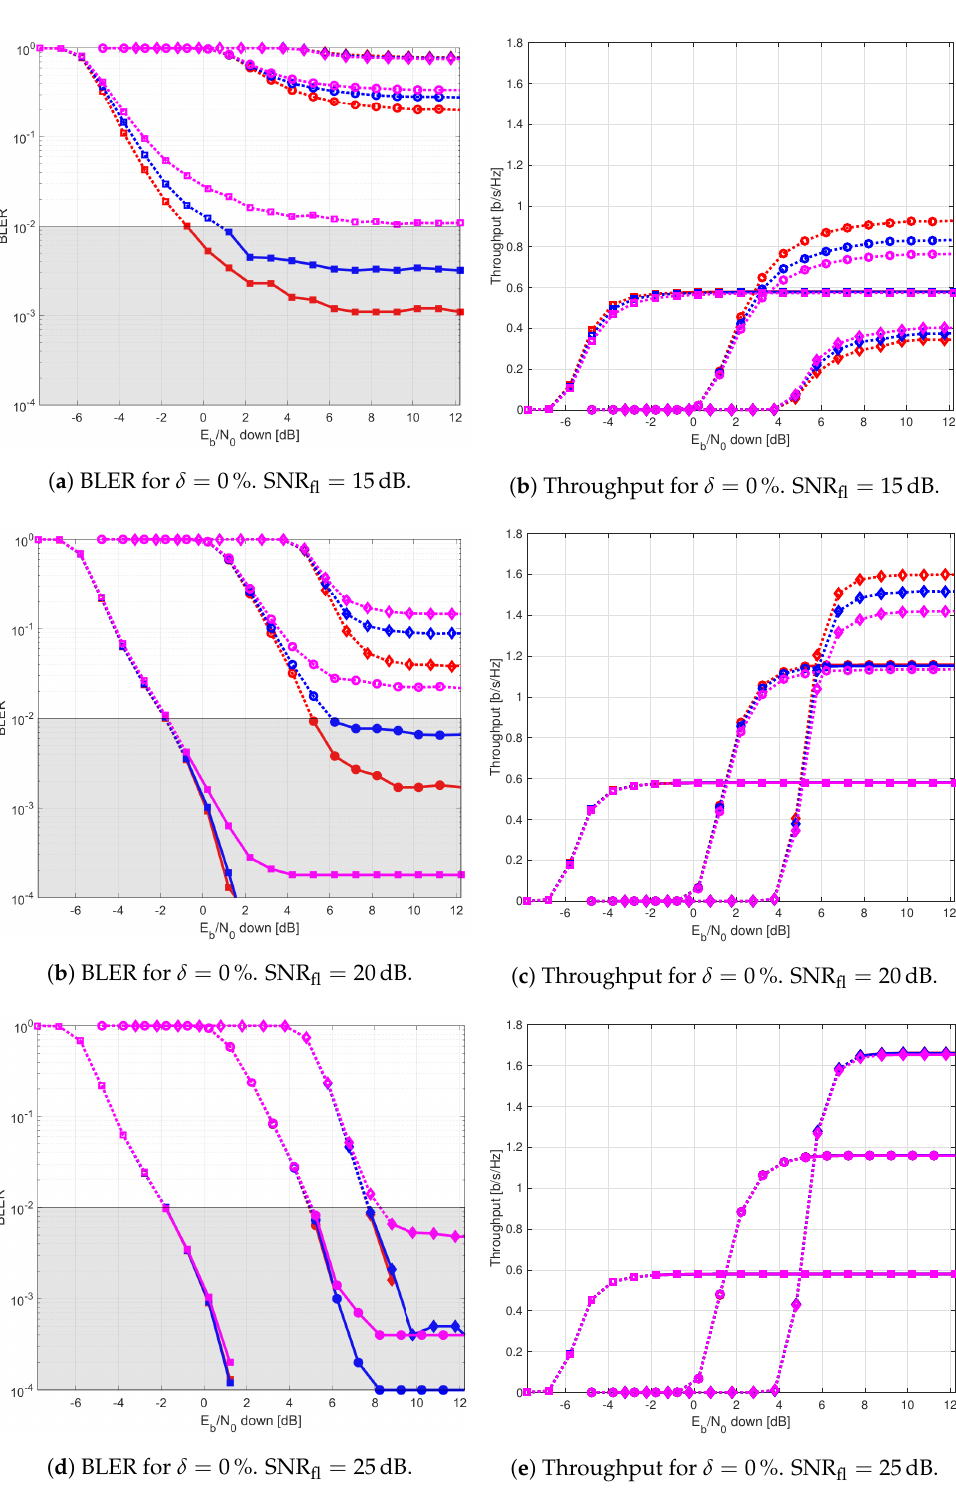
Figure 10. End-to-end BLER (left) and throughput (right) versus E b / N 0 in the access link for a NB-IoT frame (SNR fl = 15, 20, and 25dB). NB-IoT code rates: 0.33333 (square), 0.66667 (circle), and 0.95556 (diamond), when the wind speed is v = 10m/s (red), v = 21m/s (blue) and v = 30m/s (magenta). Solid (dashed-) lines with (un)filled markers: BLER ≤ 10 − 2 requirement (not) fulfilled. Diameter of telescope aperture: W 0 =